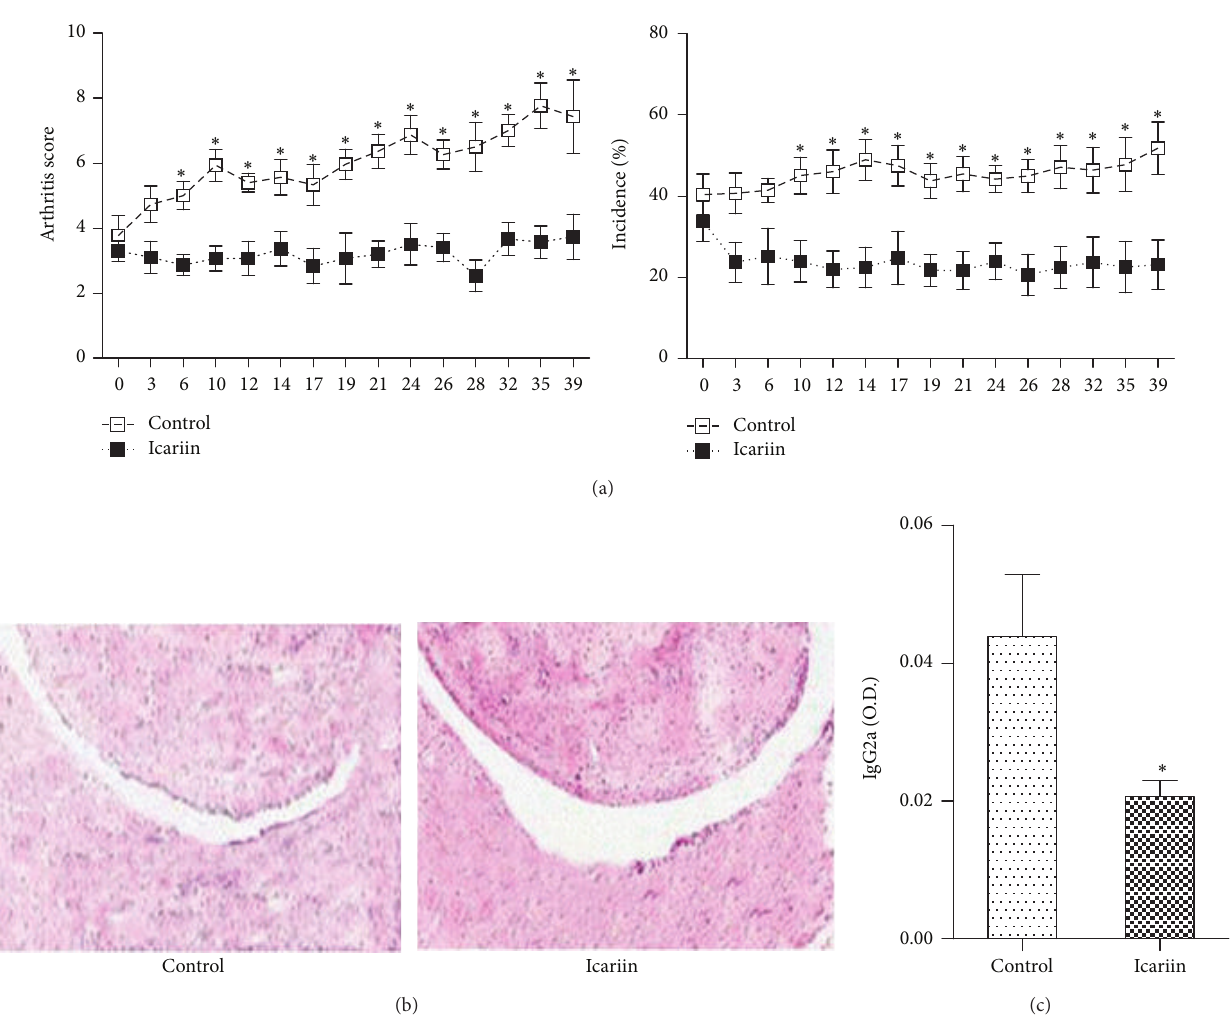
Figure 1: Icariin suppresses inflammatory arthritis in mice. (a) Arthritis score and incidence of arthritis in mice with CIA following treatment with icariin or control. (b) Histologic examination of the joints from mice with CIA in each group. (c) Levels of circulating IgG2a in the serum of mice with CIA. ∗ 𝑃 < 0.05 versus all other groups, 𝑛 = 6